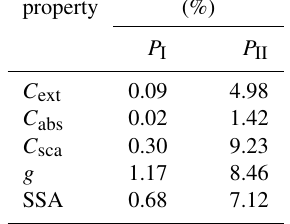
Table 5. Comparison between the relative RMSEs of param- eterization schemes over a single case of BCFA ( D f = 1.7, f organics = 60%, and λ = 660nm). The errors on the left ( P I ) are for the original scheme developed in this study, whereas the errors on right show the errors resulting from P II , which is the condensed form of P I , i.e. D f = 1.5–1.7, and f organics = 60%–90%. Optical Relative